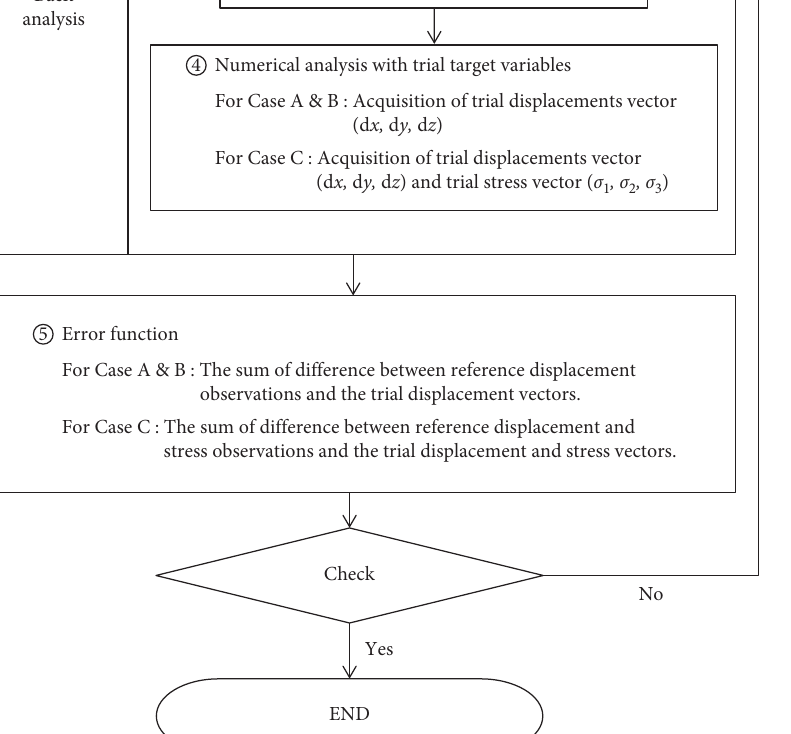
Figure 7: Flowcharts of back analysis based on DEA using monitored radial displacement and